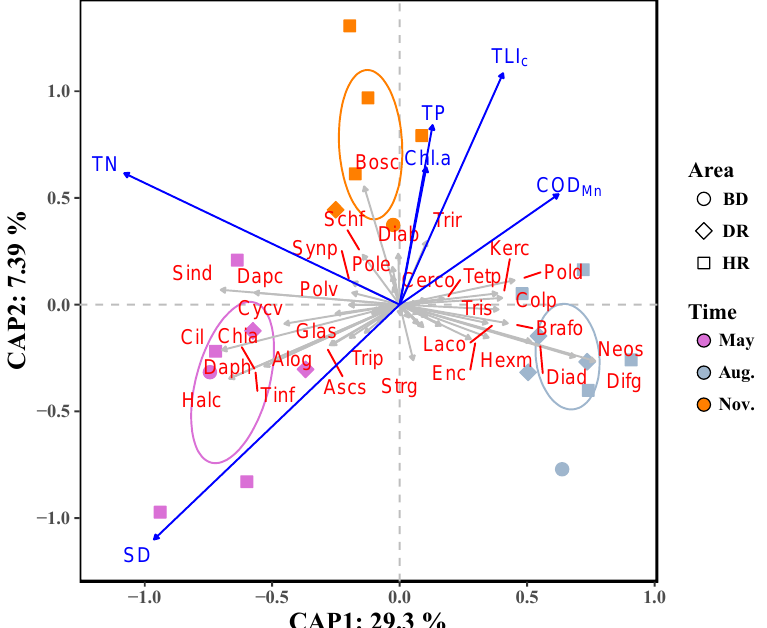
Figure 7. Results of Distance-based redundancy analysis (db-RDA) on the relationship between zooplankton (based on the presence/absence data of all the taxa) and environmental parameters (scaling = 2). Confidence intervals for the sites in different sampling months are represented by the ellipses (confidence level: 0.95). SD: Secchi disk depth, Chl. a : chlorophyll a , TN: total nitrogen, TP: total phosphorus, COD Mn : permanganate index. HR: Hanjiang reservoir area, DR: Danjiang reser-